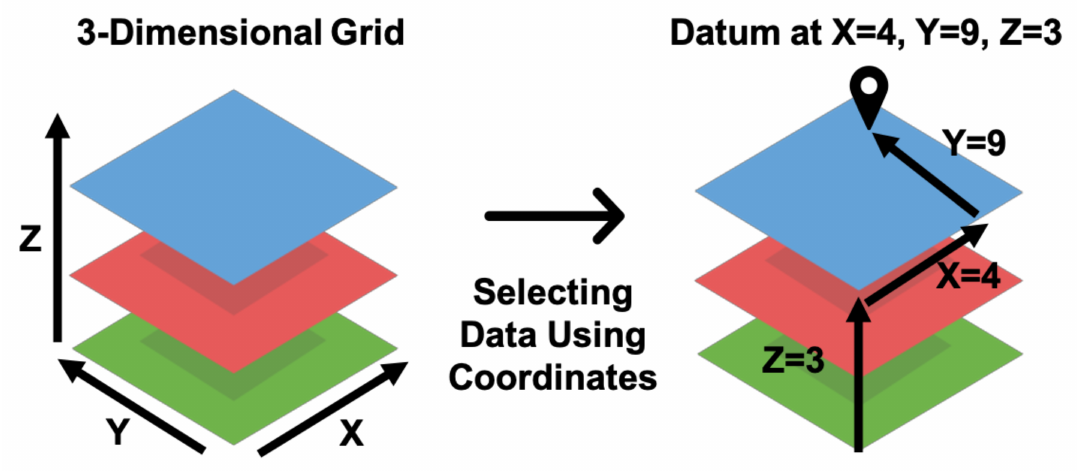
Figure 2. Locating Data in a Three-Dimensional Grid with (X, Y, Z) Coordinate Values. Grids maps a specified volume to the data in the file but may map certain coordinates to points and others to ranges depending on the resolution of the dimensions. A set of minimum and maximum coordinates could map to the same cell if the distance between the minimum and maximum is less than the distance between grid points on that